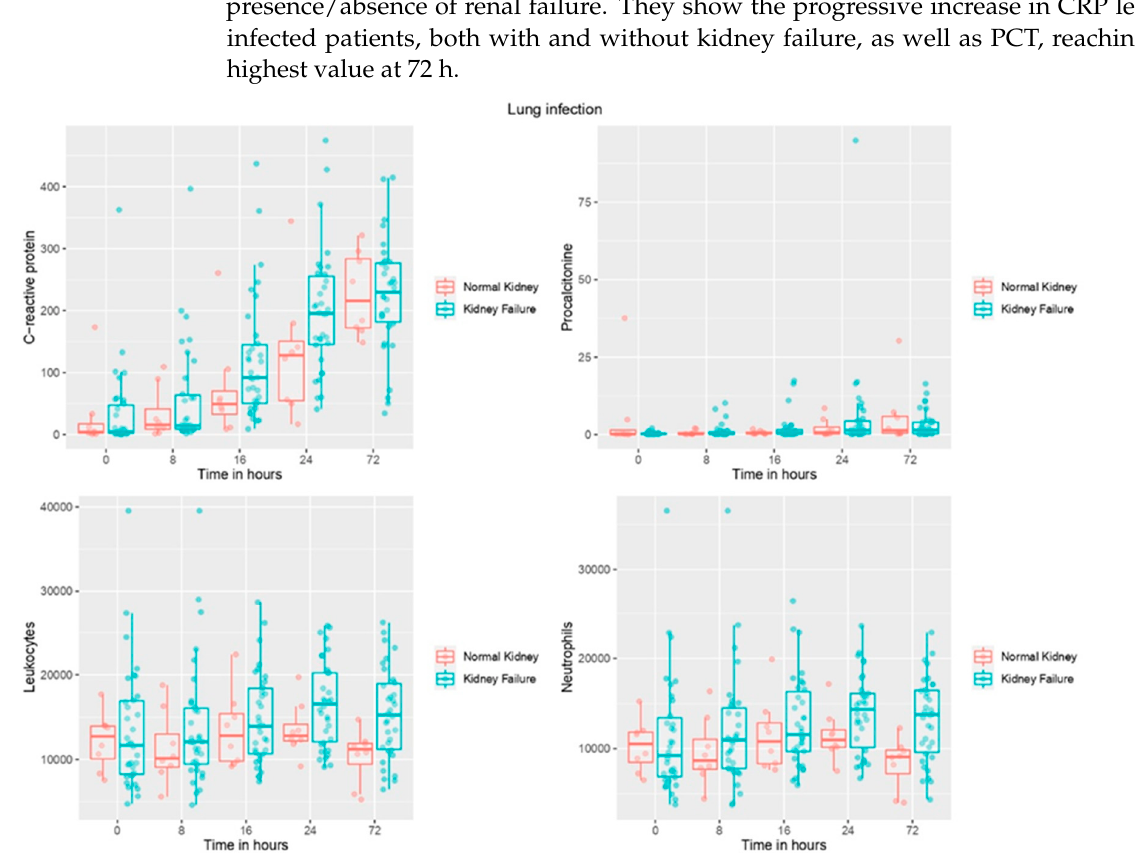
This comparison revealed that PCT levels, white blood cells and neutrophil counts at 16 h and 24 h were significantly higher in non-infected patients with renal failure. Likewise, PCT and C-Reactive protein levels were significantly higher in this group of patients at 48 h and 72 h (Table 3). In Figure 2, box plots show biomarker levels over time in non-infected patients based on the presence/absence of renal failure.